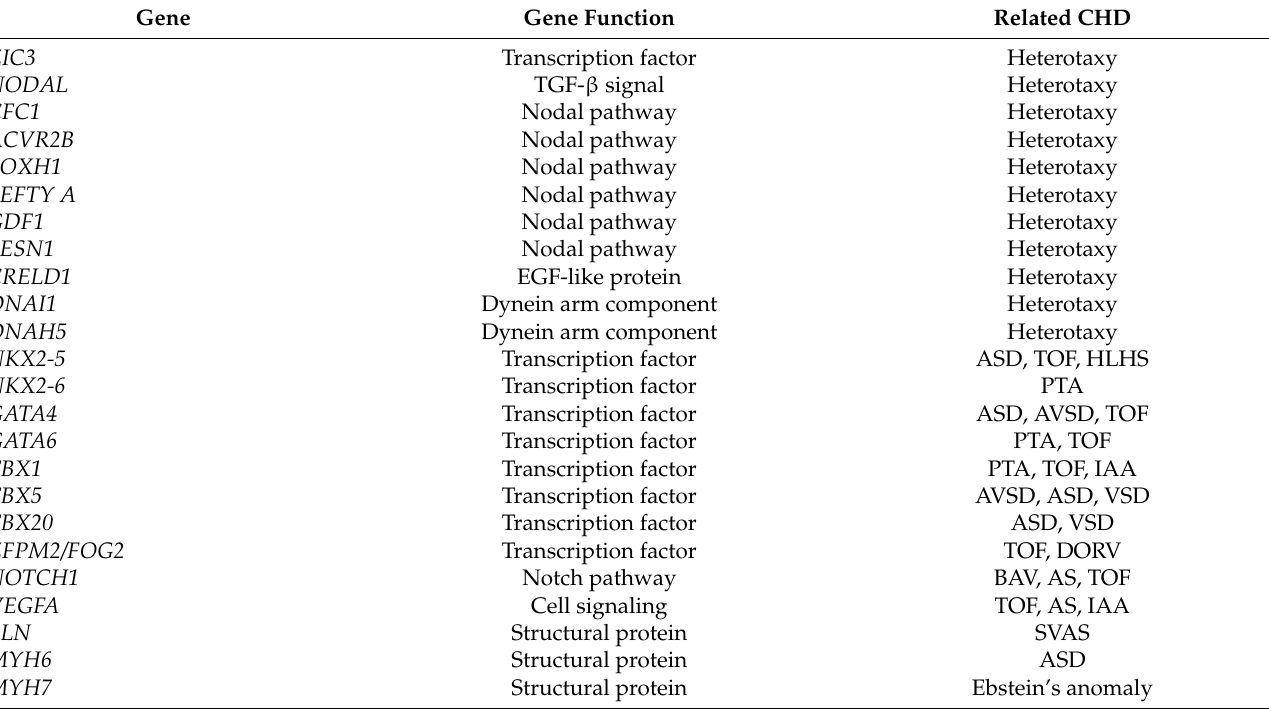
Table 1. Selected genes associated with heterotaxy and various congenital heart disease (CHD). AS, aortic stenosis; ASD, atrial septal defect; AVSD, atrioventricular septal defect; BAV, bicuspid aortic valve; DORV, double-outlet right ventricle; HLHS, hypoplastic left heart syndrome; IAA, interruption of aortic arch; PTA, persistent truncus arteriosus; SVAS, supravalvular aortic stenosis; TOF, tetralogy of Fallot; VSD, ventricular septal